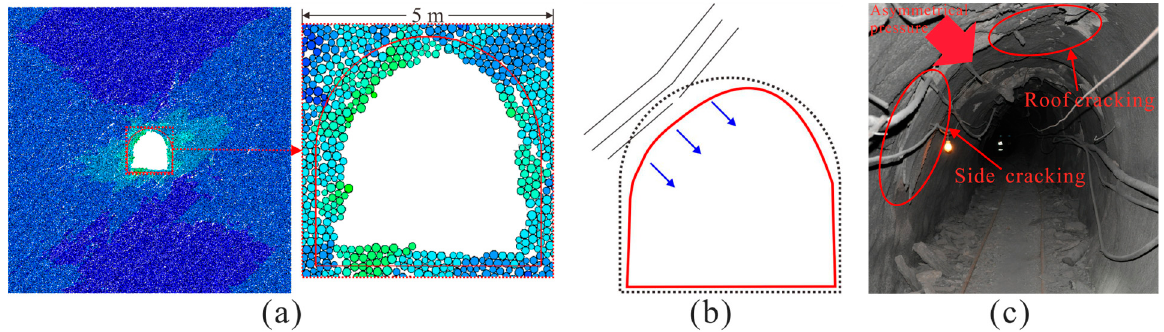
Figure 11. Schematic diagram of asymmetrical pressure failure. ( a ) Numerical simulation result; ( b ) Failure mechanism; ( c ) Field representation.